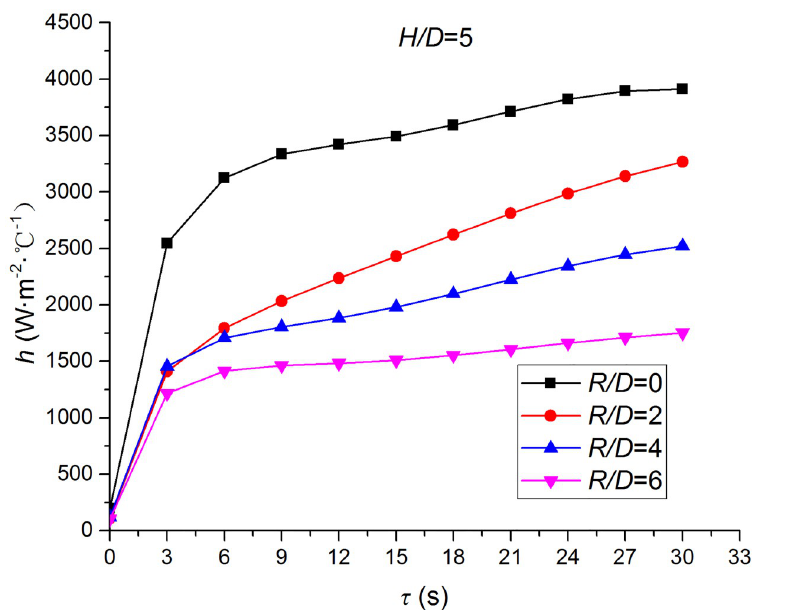
Fig 20. Distribution and variation of the convective heat transfer